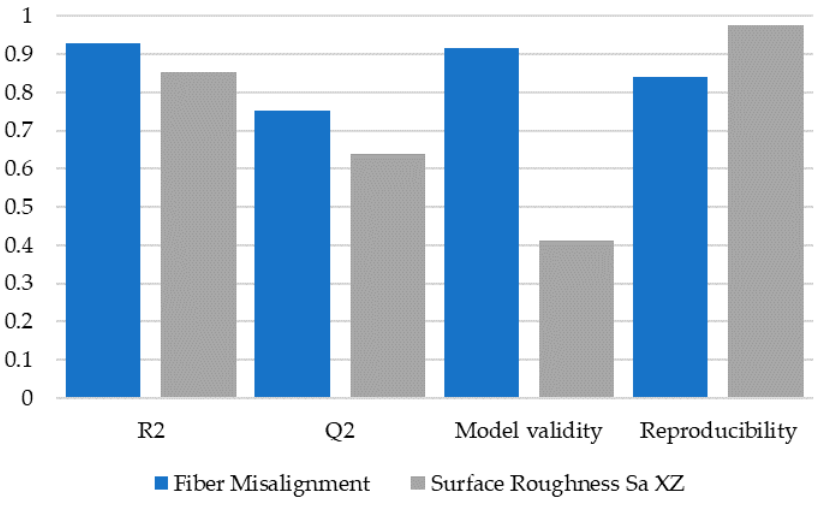
Figure 17. DoE model quality indicators.